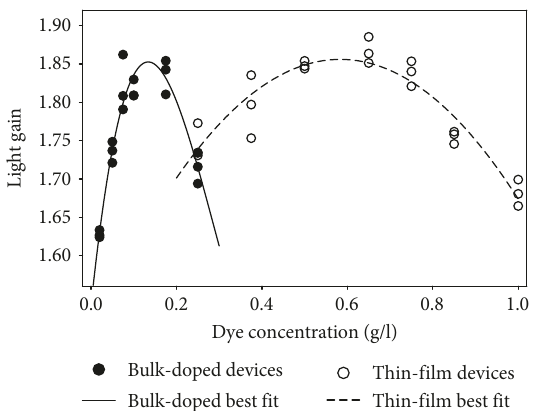
Figure 4: Light gains of bulk-doped and thin- fi lm devices plotted against dye concentration. Bulk-doped devices were optimized for light gain with LR305 concentrations between 0.075 and 0.175g/l. Thin- fi lm devices were optimized between 0.5 and 0.75g/l. Best fi t second-order polynomials are included to visualize trends in each data